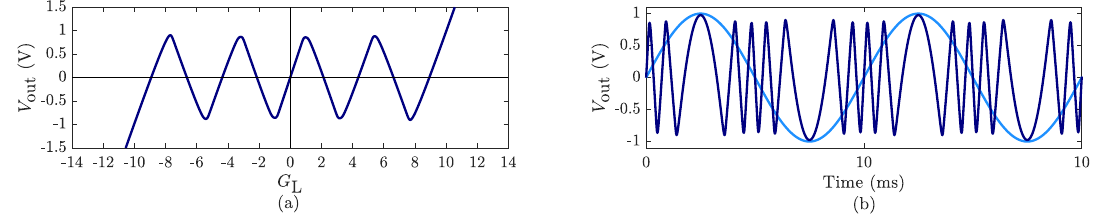
Figure 20. ( a ) Transfer function of the proposed cascaded Lockhart wavefolder structure measured after the post-gain block; and ( b ) its output when driven by a 100-Hz sinusoidal input for G L = 10 and zero dc